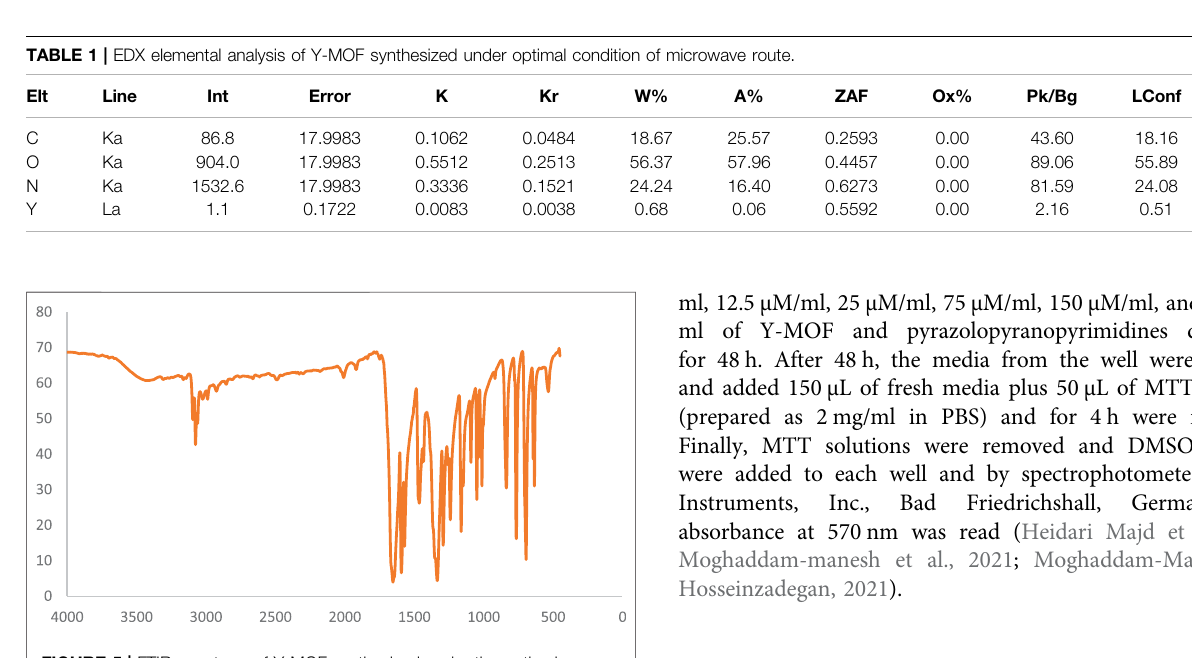
Frontiers in Chemistry |